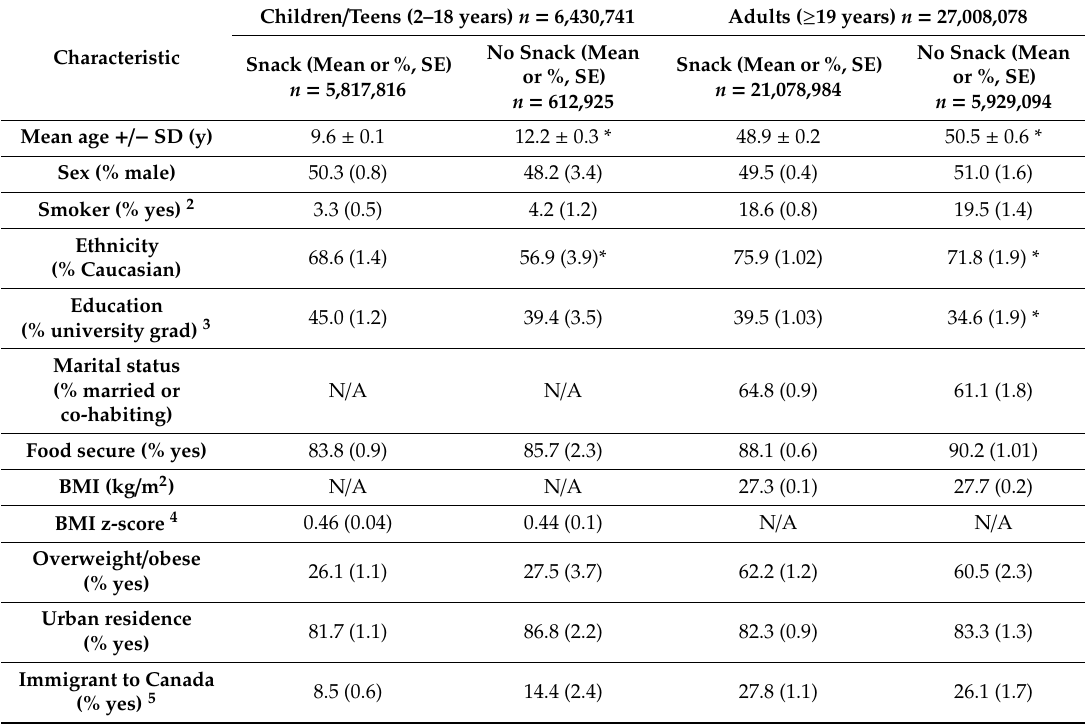
Table 1. Sociodemographic characteristics of Canadian children (2–18 years) and adults (19 + years) as snack consumers and non-consumers 1